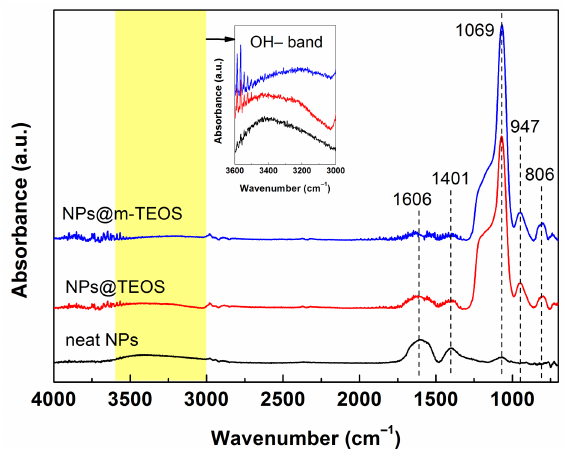
Figure 3. FTIR spectra for the neat NPs, NPs@TEOS and NPs@m-TEOS particles with denoted characteristic